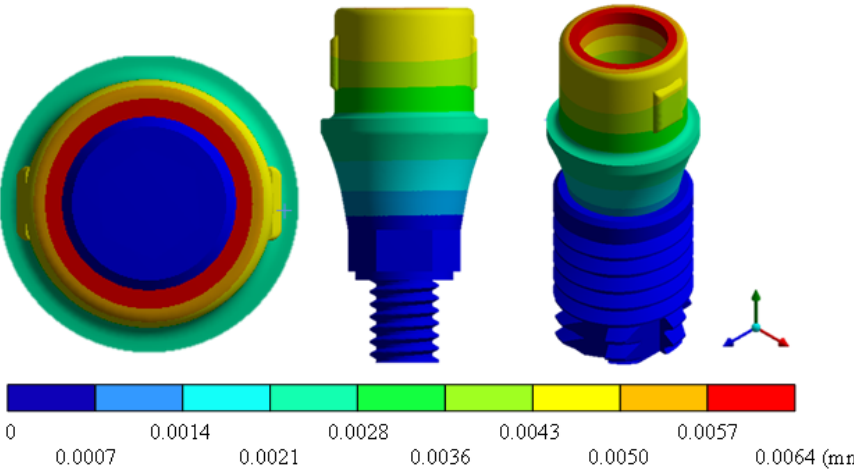
Figure 12. Von Mises stress for Snappy-type implant (Ti 6 Al 4 V).